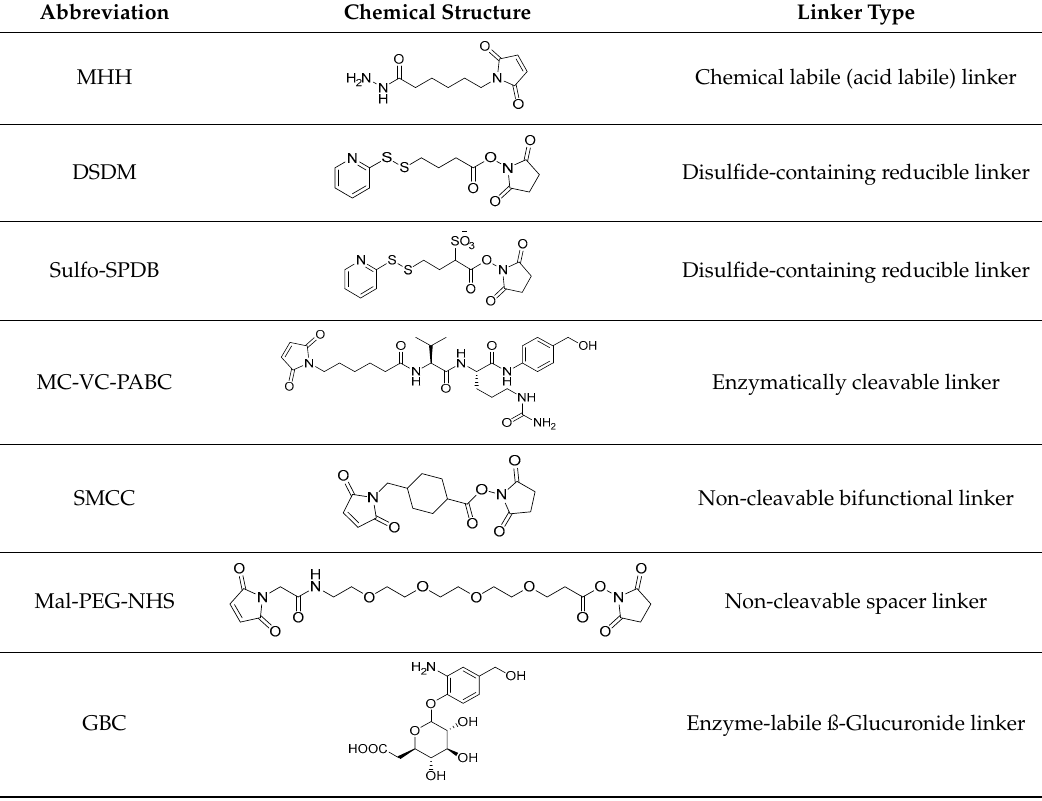
Table 1. Summary of commonly used linkers for the development of ADCs.